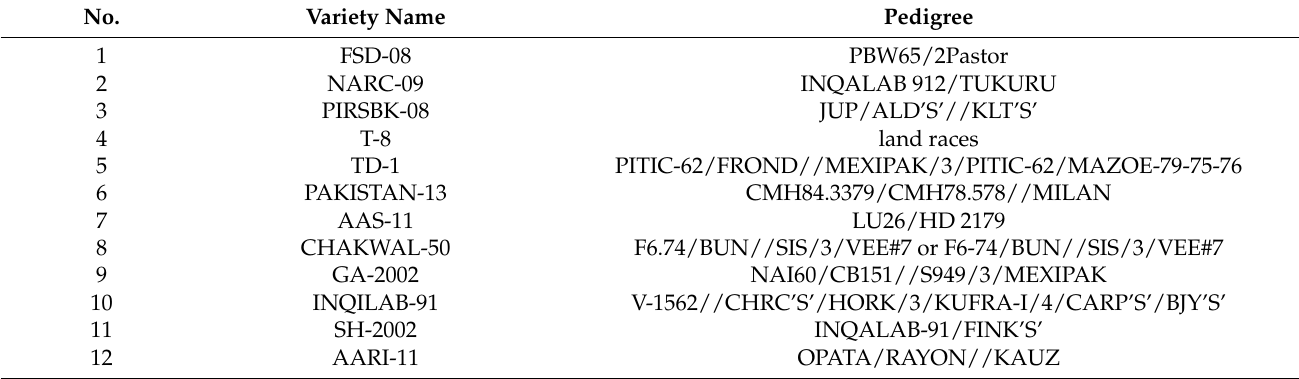
Table 3. Detailed description of studied plant